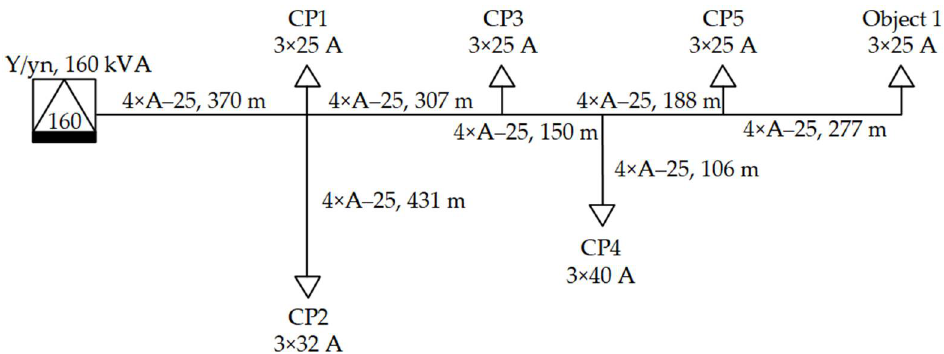
Figure 5. DIgSILENT PowerFactory single-line diagram model representation of Grid 1 from Group 1, representing a typical low voltage feeder with very small one phase short-circuit impedances and long distances to consumers.